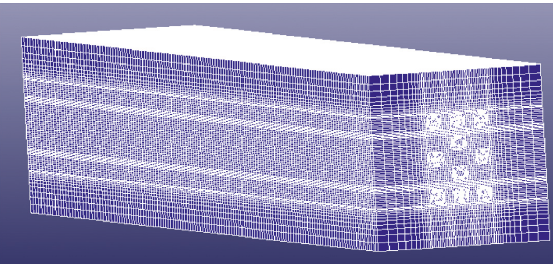
Figure 2: Numerical calculation model. Table 1: Material parameters.